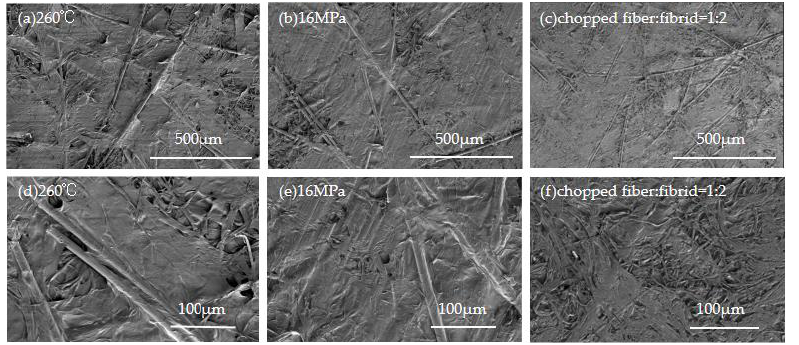
Figure 13. Micromorphology of insulating paper when hot pressing temperature, pressure, and precipitating fiber content are high.